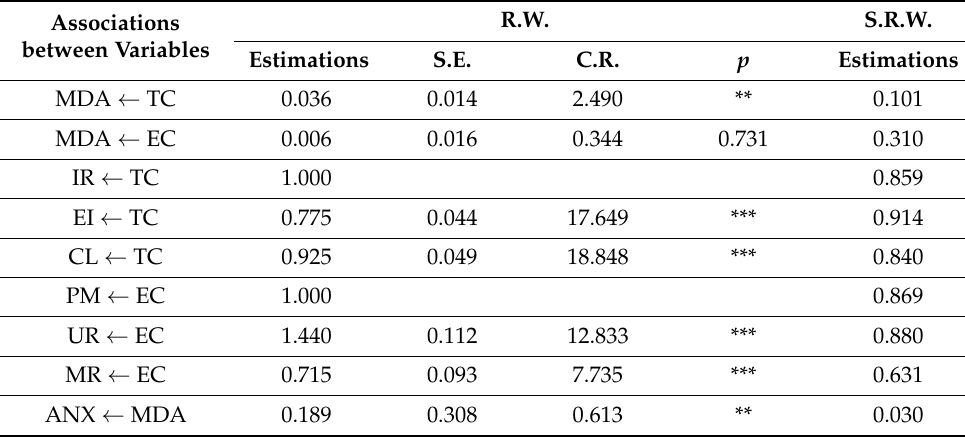
Figure 2. Theoretical model proposed for participants showing a low level of weekly PA. Note: EC = Ego climate; TC = Task climate; PM = Punishment for mistakes; UR = Unequal recognition; MR = Member rivalry; CL = Cooperative learning; EI = Effort/improvement; IR = Important role; ANX = Anxiety; MDA = Mediterranean diet adherence. Table 2. Structural model for participants showing a low level of weekly PA.